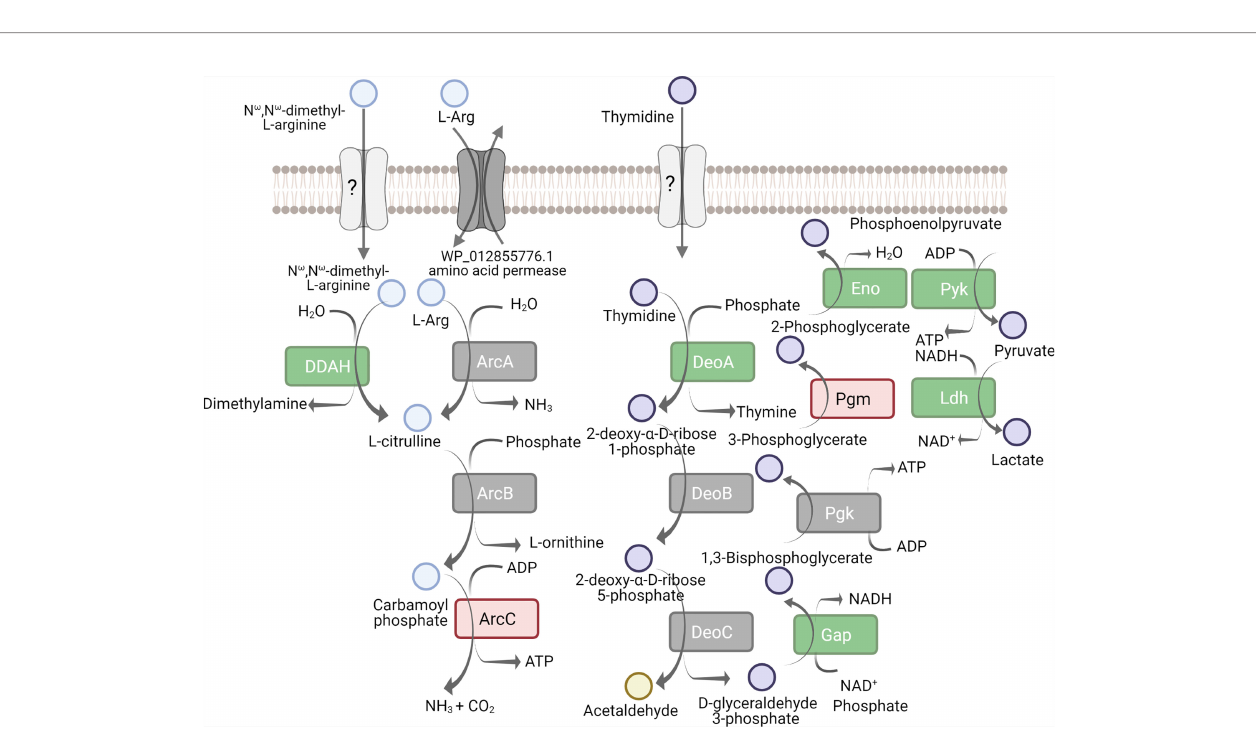
FIGURE 4 | Proteins implicated in the arginine deiminase pathway and utilization of pyrimidine deoxynucleoside as energy source. Comparative proteomic analysis of M. hominis grown on thymidine-supplemented medium relative to arginine-supplemented medium. The down-regulated proteins are indicated red, up-regulated - in green, unchanged - in grey. Unknown proteins are in light grey. The full names of proteins are given in Supplementary Tables S3 , S4 .